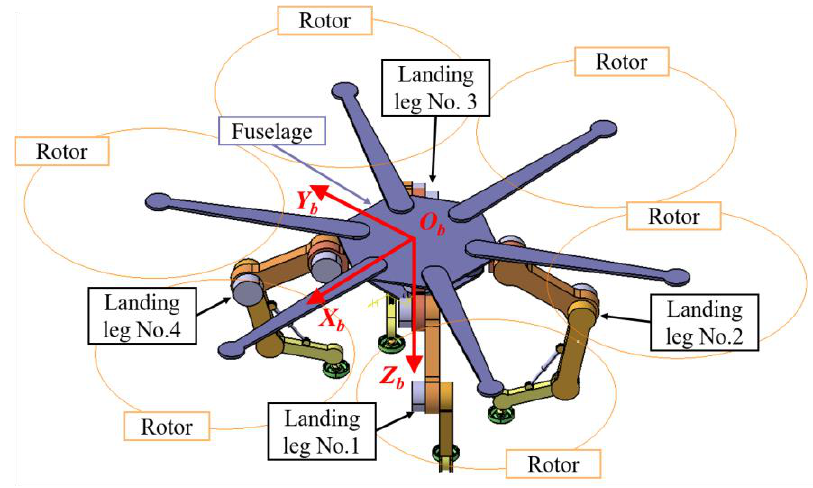
Figure 2. The virtual prototype model of the multirotor UAV in CATIA.